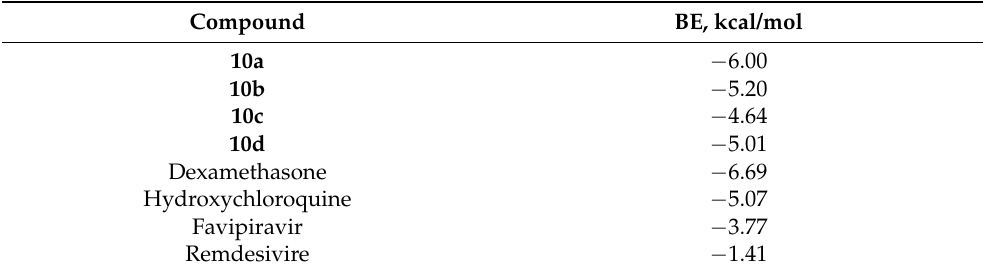
Table 3. Docking simulation results with Docking Score Energy. Binding energy (BE) between ferrocenes 10a – 10d , drugs, and 6LU7 Protein of SARS-CoV-2; data from [16]. Compound